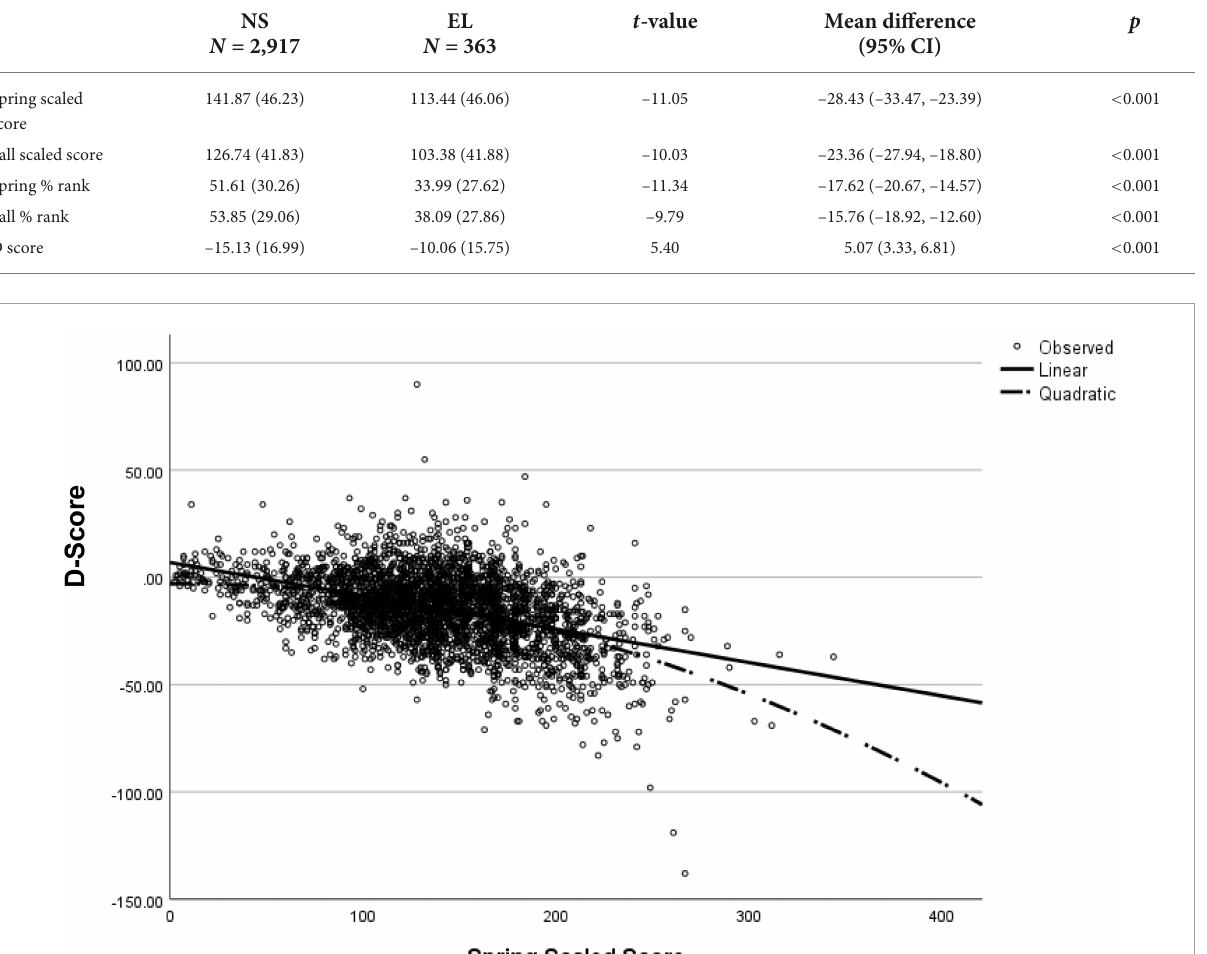
fall scores ( β = 0.89, p < 0.001, R 2 = 0.80; see Table 2 ). The